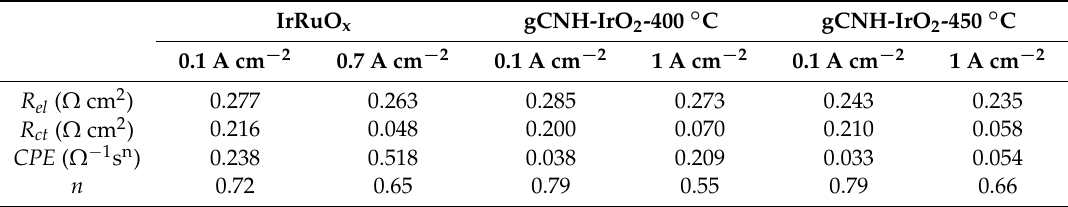
Table 1. EIS fitted parameters of the data shown in Figure